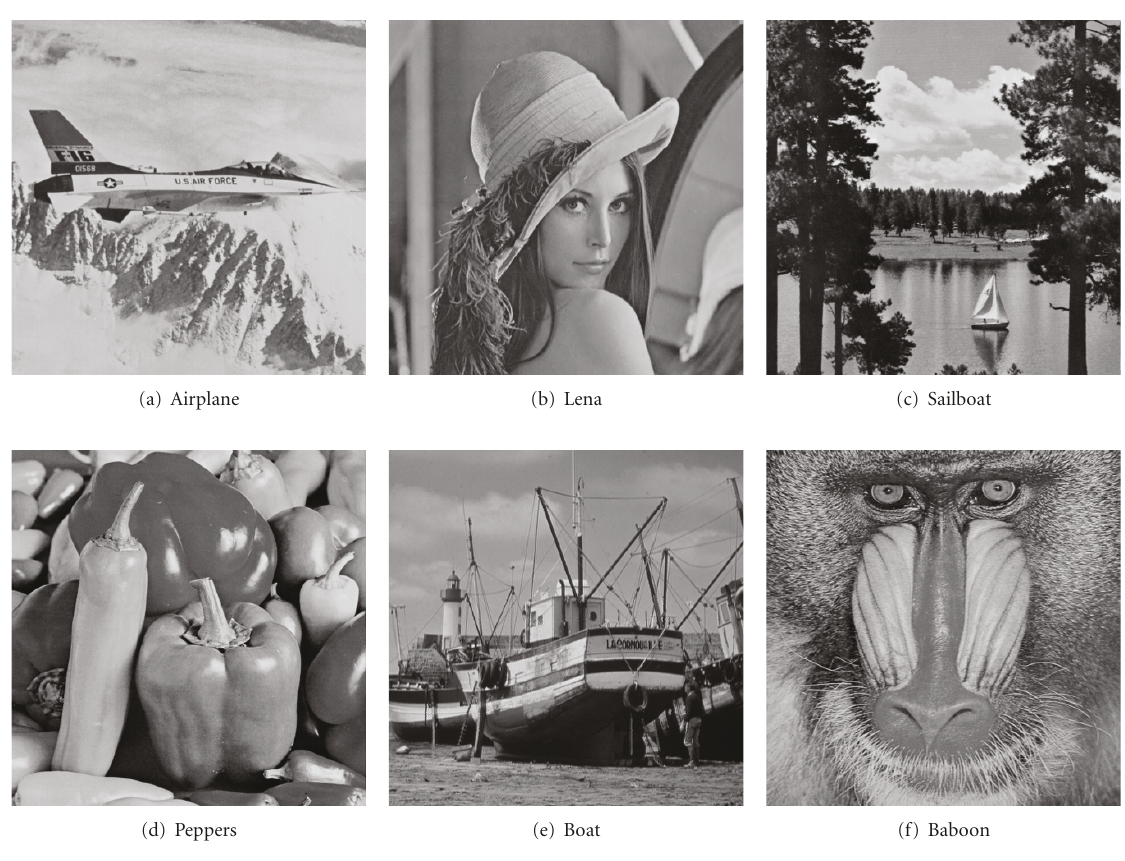
Figure 8: Six standard grayscale images.